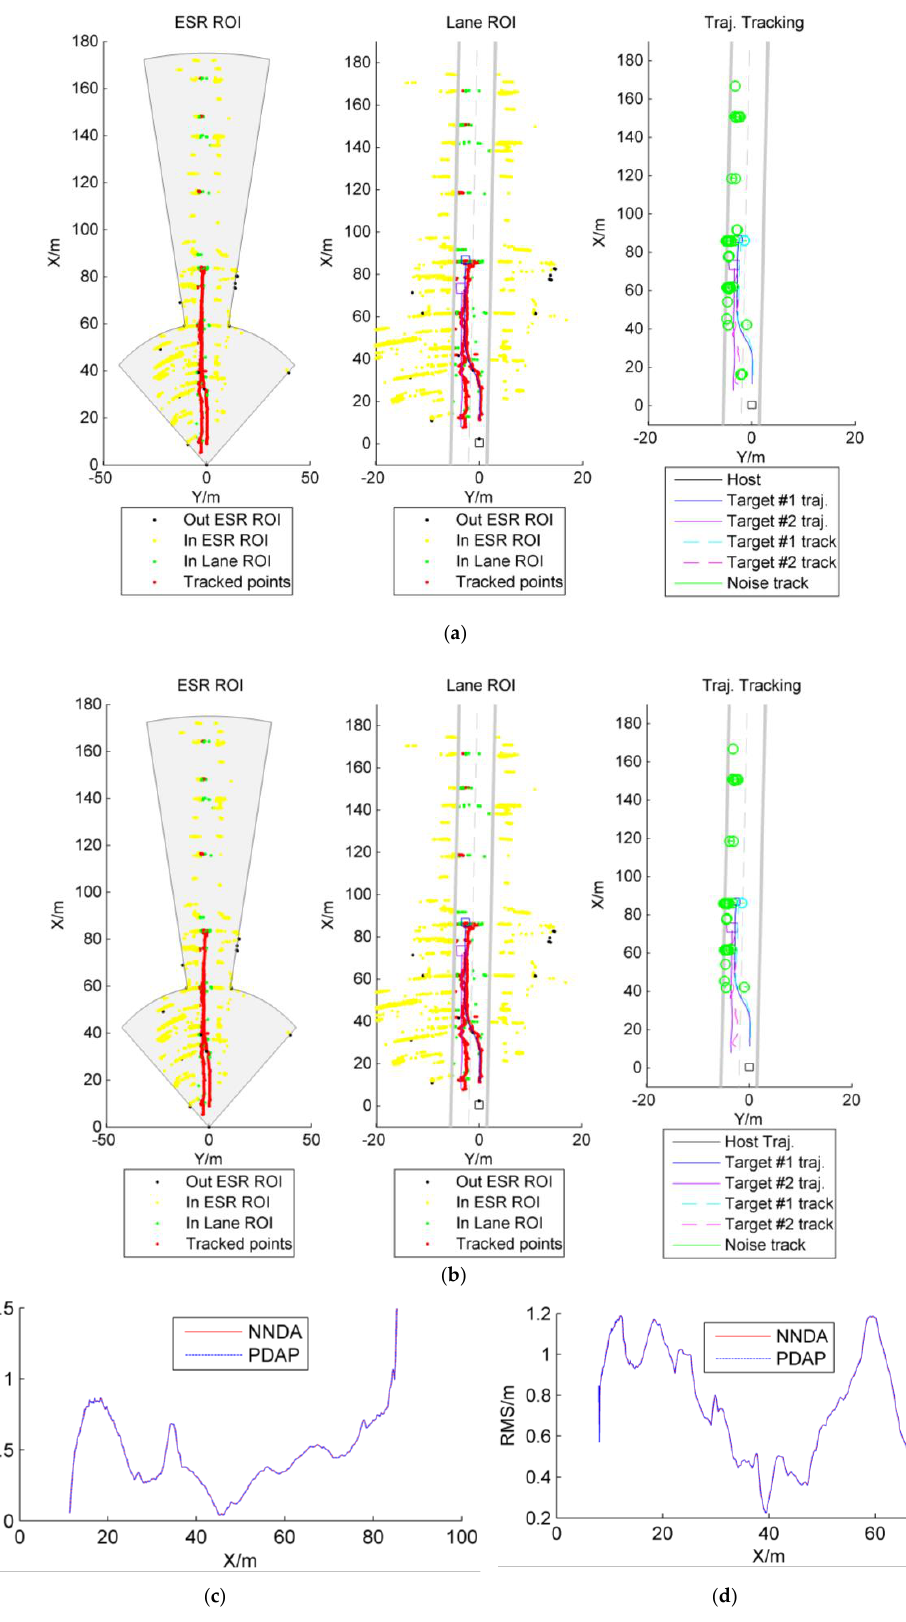
Figure 5. Real test for scenario 1. ( a ) NNDA-CT-UKF multitarget tracking; ( b ) PDAP-CT-UKF multitarget tracking; ( c ) RMS for tracking target #1; ( d ) RMS for tracking target #2.